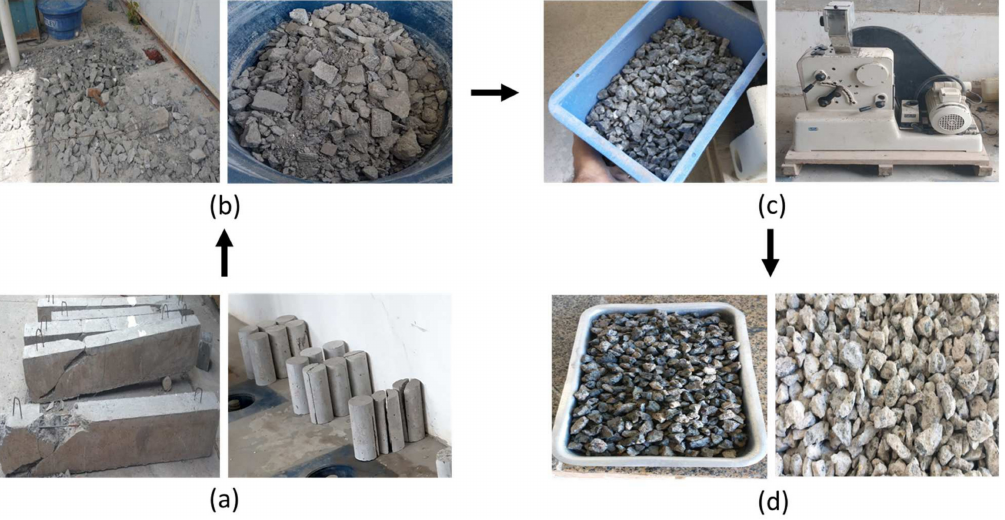
Figure 4. Scheme for the production of recycled coarse aggregates; ( a ) specimens from previous tests with concrete having a compressive strength between 50 MPa and 70 MPa were collected; ( b )